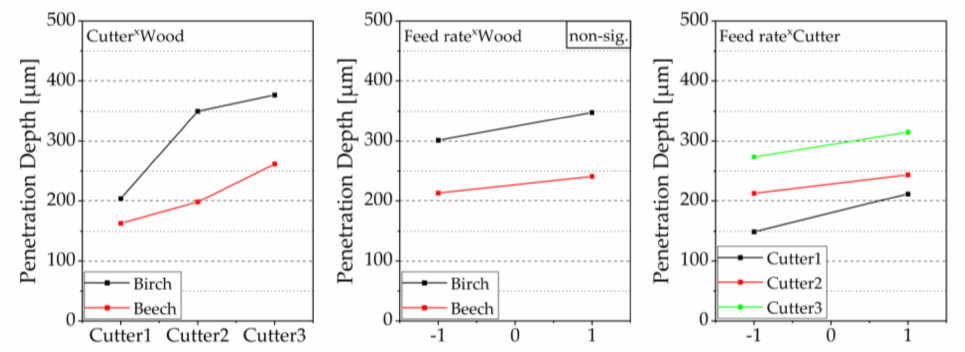
Figure 13. 2-way interactions of the penetration depth for different cutting combinations, mean values of the factors are shown, interactions are visualized based on the courses of the effect lines; please see explanatory Figure